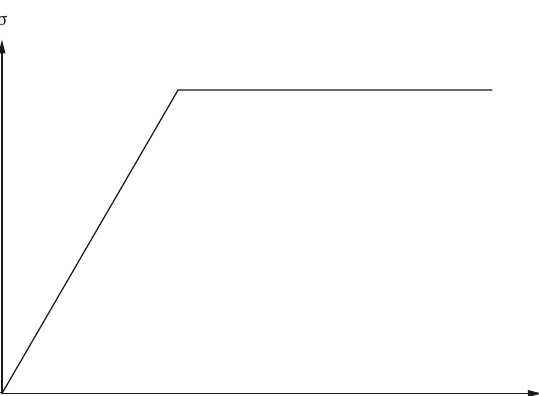
Figure 8: Idealization of the steel stress-strain curve [28].